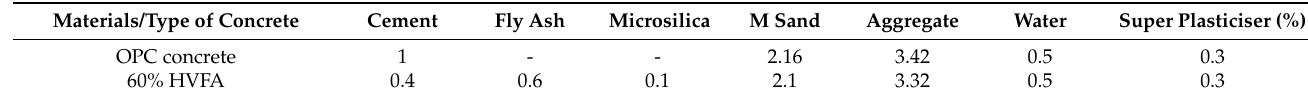
Table 2. The mix design of concrete arrived as per the Indian standard IS: 10262 and IS: 456. Table 1. Mix proportion of concrete.